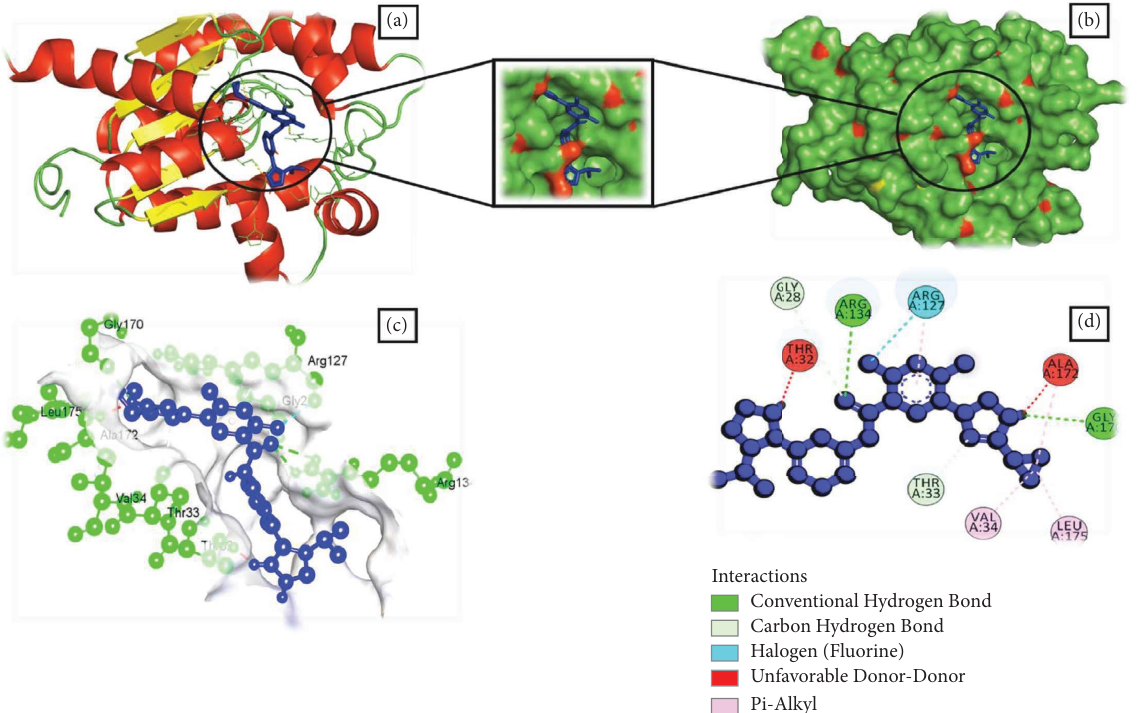
Figure 4: Schematic representation of Shikimate kinase_CHEMBL3916717 complex. (a) Pose view of Shikimate kinase_CHEMBL3916717 complex. (b) Surface view of Shikimate kinase_CHEMBL3916717 complex. Here, protein is in red, yellow, and green color and ligand is in blue color. (c, d) 3D and 2D interaction of Shikimate kinase_CHEMBL3916717 complex. Here, protein is in green color and ligand is in blue color.